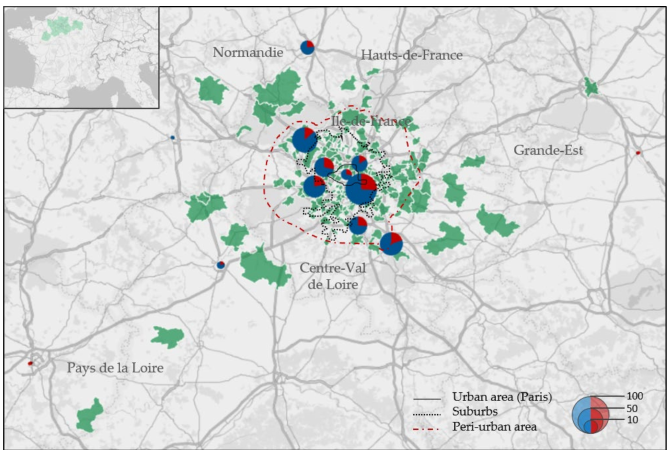
Figure 1. Geographical origin of dermatophyte-negative (blue) and -positive (red) hedgehogs on their arrival at the rescue centre in 2016. Green-coloured regions correspond to departments (upper-left panel) or postal codes (main panel) from where hedgehogs were found. Laboratory results have been grouped by departments. Paris city is included. Size of the circles indicates the number of animals sampled. Administrative and landscaped divisions in Île de France have been adapted from the French Institute of Statistics and Economic Studies